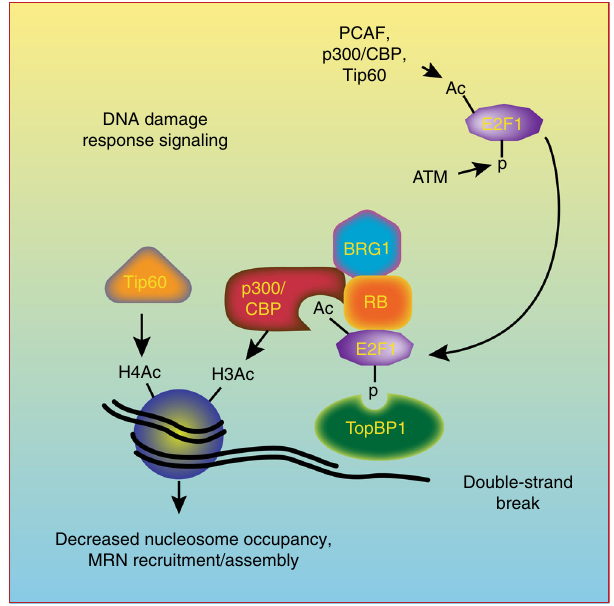
Fig. 8 Posttranslational modi fi cations regulate E2F1 recruitment and function at DSBs. E2F1 phosphorylation recruits E2F1 and RB to sites of DNA damage via an interaction with TopBP1, while E2F1 acetylation creates a binding motif for the bromodomains of p300 and CBP allowing E2F1 and RB to direct p300/CBP-mediated H3 acetylation in chromatin fl anking DSBs. E2F1 phosphorylation and acetylation are also important for the recruitment of Tip60 and BRG1 to sites of DNA damage and for loading of the MRN